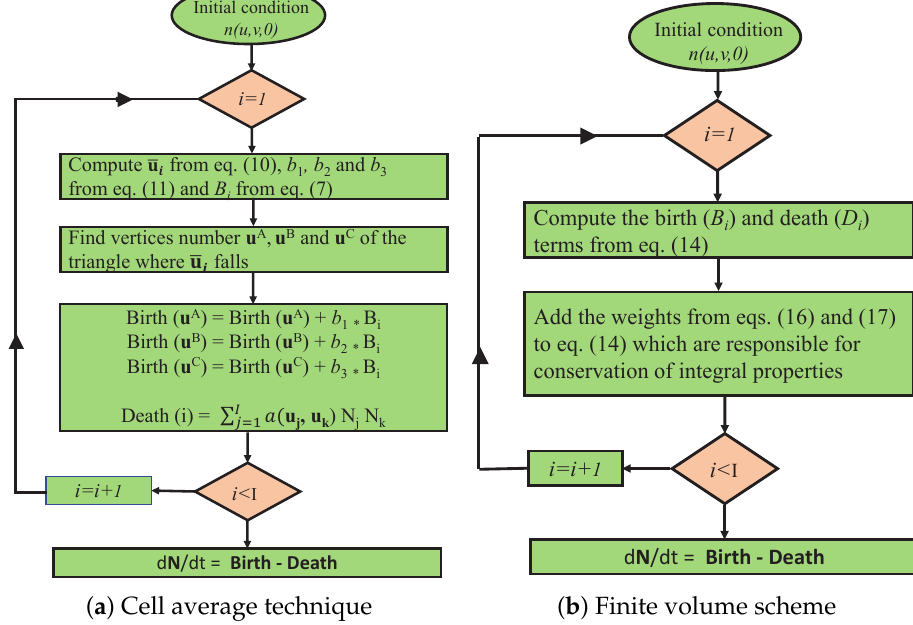
Figure 2. Work flowcharts of the algorithms of the numerical